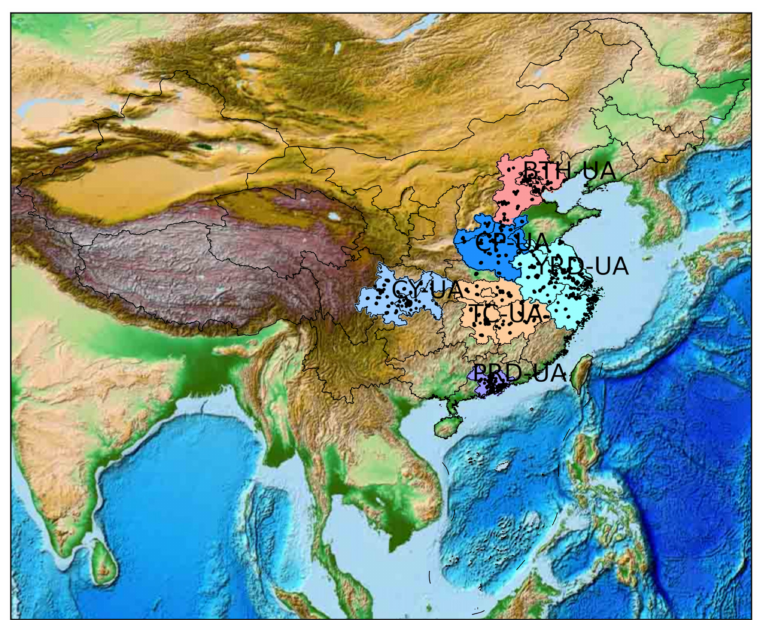
Figure 1. The locations of six major urban agglomerations in China: Beijing–Tianjin–Hebei ur- ban agglomeration (BTH-UA), Central Plains urban agglomeration (CP-UA), Yangtze River Delta urban agglomeration (YRD-UA), Triangle of Central China urban agglomeration (TC-UA), Chengdu– Chongqing urban agglomeration (CY-UA), and Pearl River Delta urban agglomeration (PRD-UA). The black dots represent air-quality monitoring